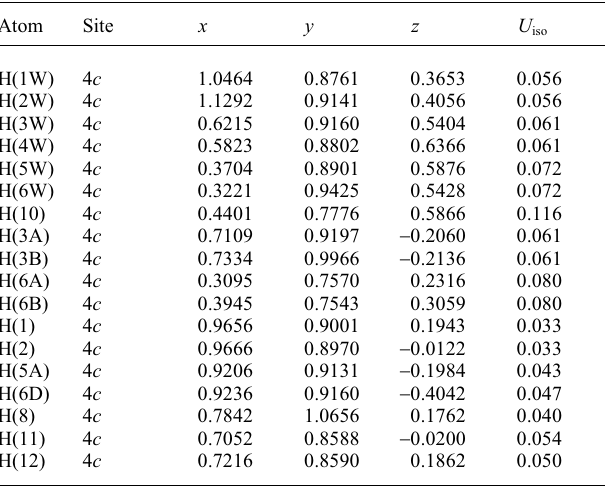
Table 3. Atomic coordinates and displacement parameters (in Å 2 ) .